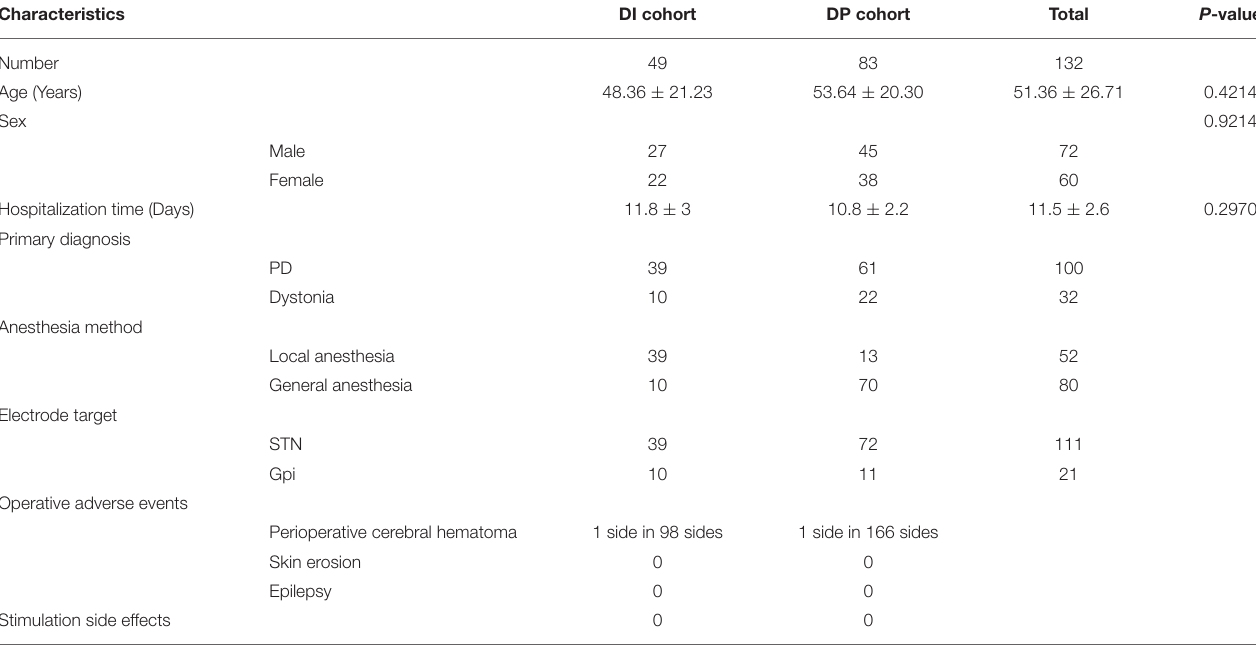
TABLE 1 | Clinical characteristics of 132 patients who underwent DBS in the Wuhan Union Hospital.